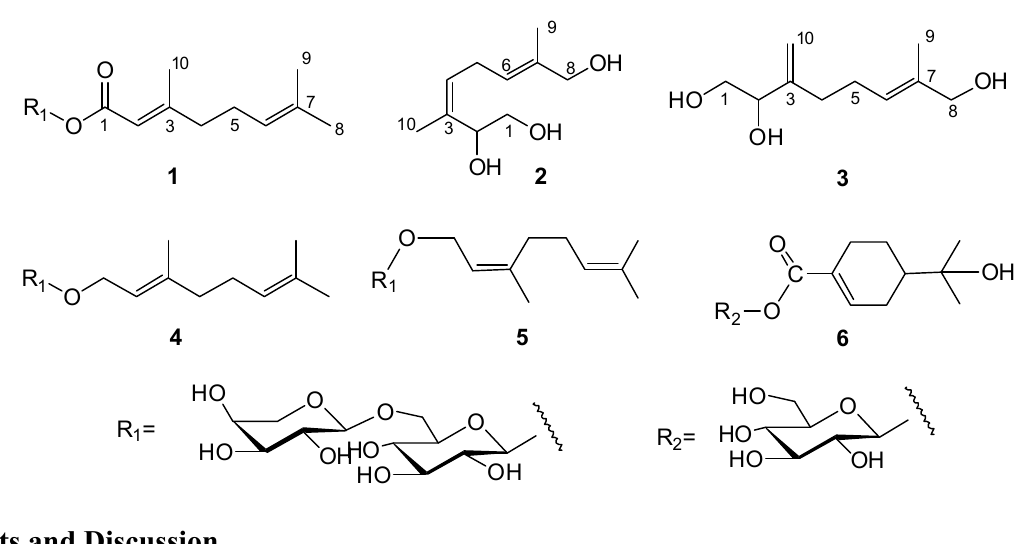
Figure 1. Structures of compounds 1 – 6